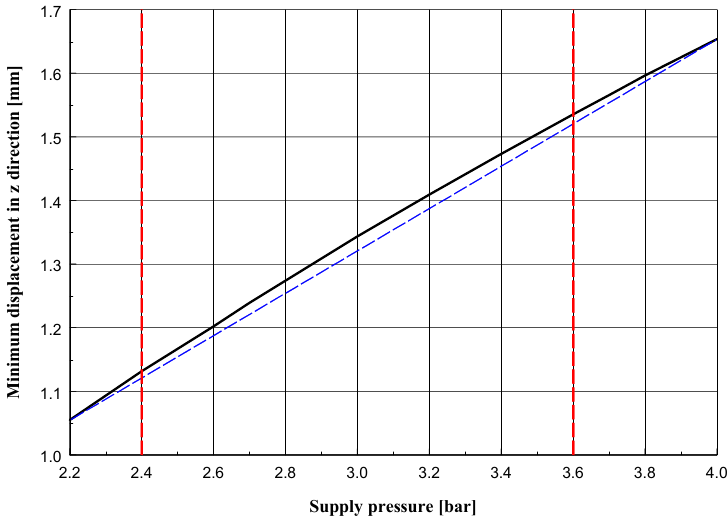
Figure 14. Displacement of roller (its part nearest to side surface) in direction perpendicular to its axis depending on pressure in supply line for h = 5 mm.